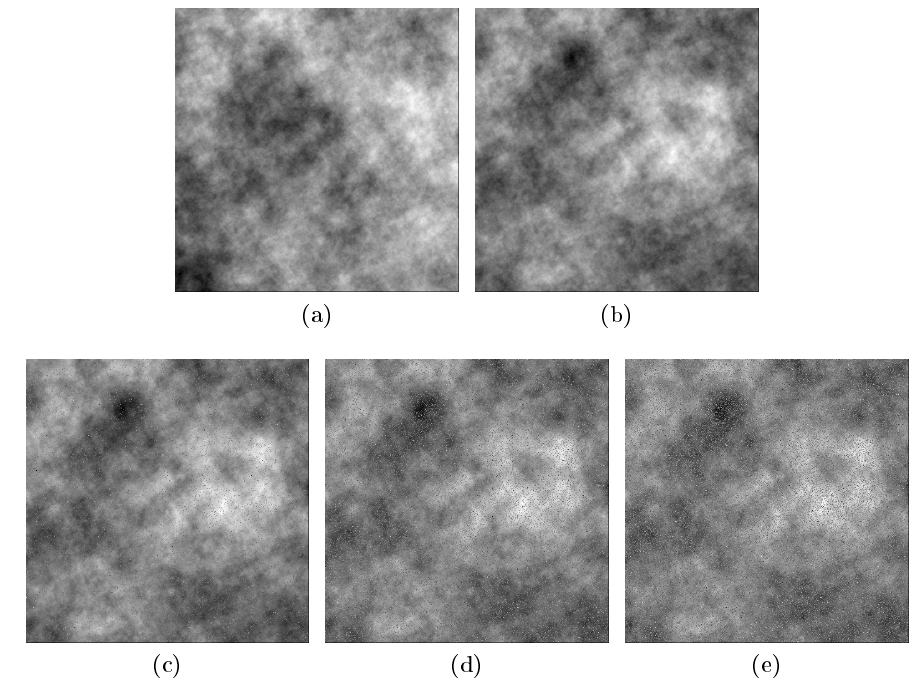
Figure 2. Images ( a , b ) are dependent processes generated from a Gaussian process with a covariance matrix as in (5); ( c – e ) salt and pepper contamination of ( b ) considering δ = ( 0.05,0.15,0.25 ) , and ν 1 = ν 2 = ν 12 = 0.5, σ 2 N × N is the size of the